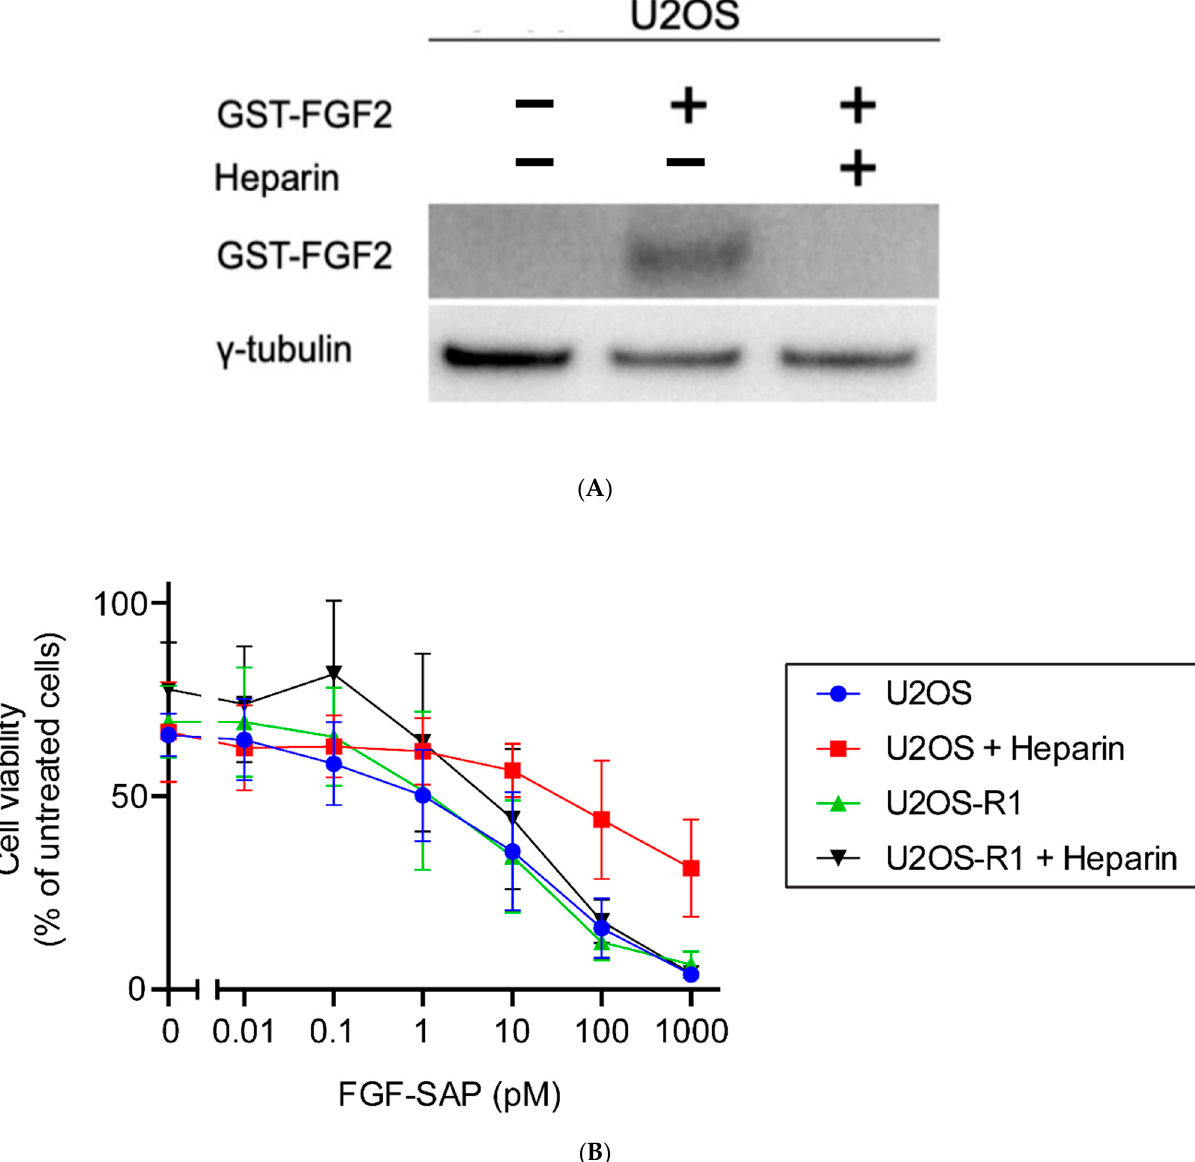
Figure 5. Involvement of HSPGs in binding and toxicity of FGF-SAP in U2OS. ( A ) Binding of GST-FGF2 in U2OS cells in the presence or absence of heparin. Cells were treated with 600 ng/mL GST-FGF2 in the presence or absence of 50 U/mL heparin, on ice for 1 h. Cells were then lysed, and the cellular material was analyzed by SDS-PAGE and Western blotting using the indicated antibodies. Representative image of one out of two experiments is shown. ( B ) Cytotoxic effects of PCI of FGF-SAP are reduced by co-treatment with heparin. Cells were incubated with 0.2 μ g/mL TPCS2a for 18 h prior to 4 h incubation with photosensitizer-free medium containing increasing concentration of FGF-SAP with or without 20 U/mL heparin. The cells were then exposed for 120 s to blue light and MTS was assessed 48 h post light exposure. The data are presented as means relative to the mean of untreated cells. The graph represents the mean of three independent experiments with three replicate samples for each condition in each experiment. Error bars ± SEM, n = 3.